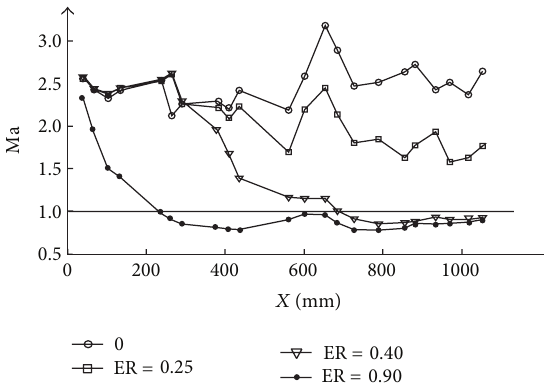
Figure 8: Oxygen mass flow rate need for ignition and flame stabilization at different ER.